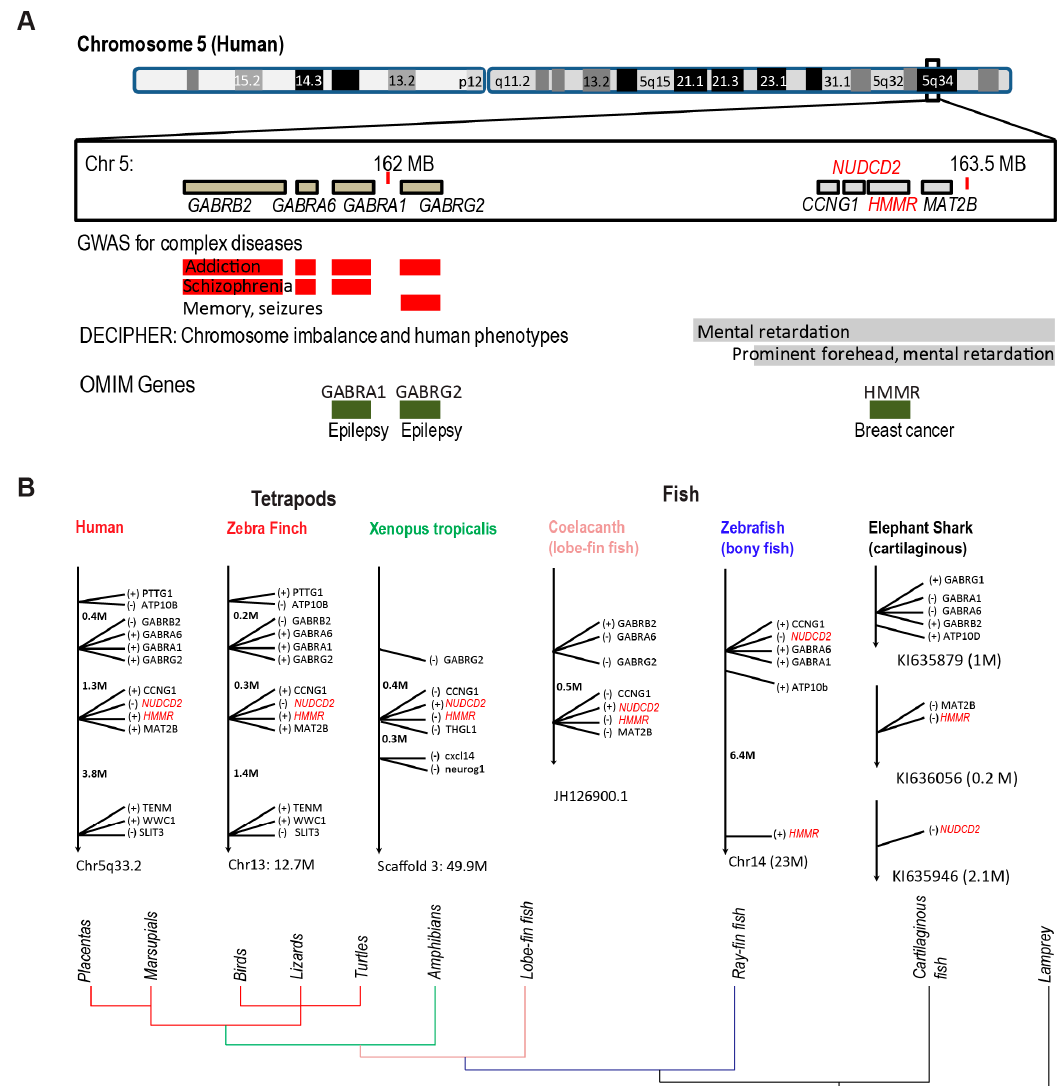
Figure 2. Conserved HMMR-NUDC domain-containing protein 2 (NUDCD2) gene cluster in tetrapods. ( A ). Chromosome location for the CCNG1-NUDCD2-HMMR and GABAA gene clusters on human chromosome 5q33.1. Importantly, NUDCD2 and HMMR are oriented in opposite directions such that their 5 ′ -ends are separated by only 530 base-pairs. The proximity of these gene clusters is conserved throughout chordates. In humans, this region of chromosome 5q associates with numerous human diseases and phenotypes related to neural development and homeostasis. ( B ). Chromosome locations for the CCNG1-NUDCD2-HMMR and GABAA gene clusters shows conservation of clusters within tetrapod species and lobe-fin fish species. The orientation of genes is indicated as forward ( + ) or reverse ( −